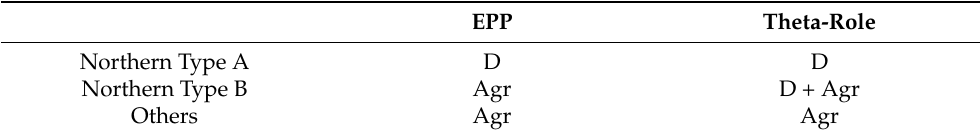
Table 7. The typology of Italo-Romance